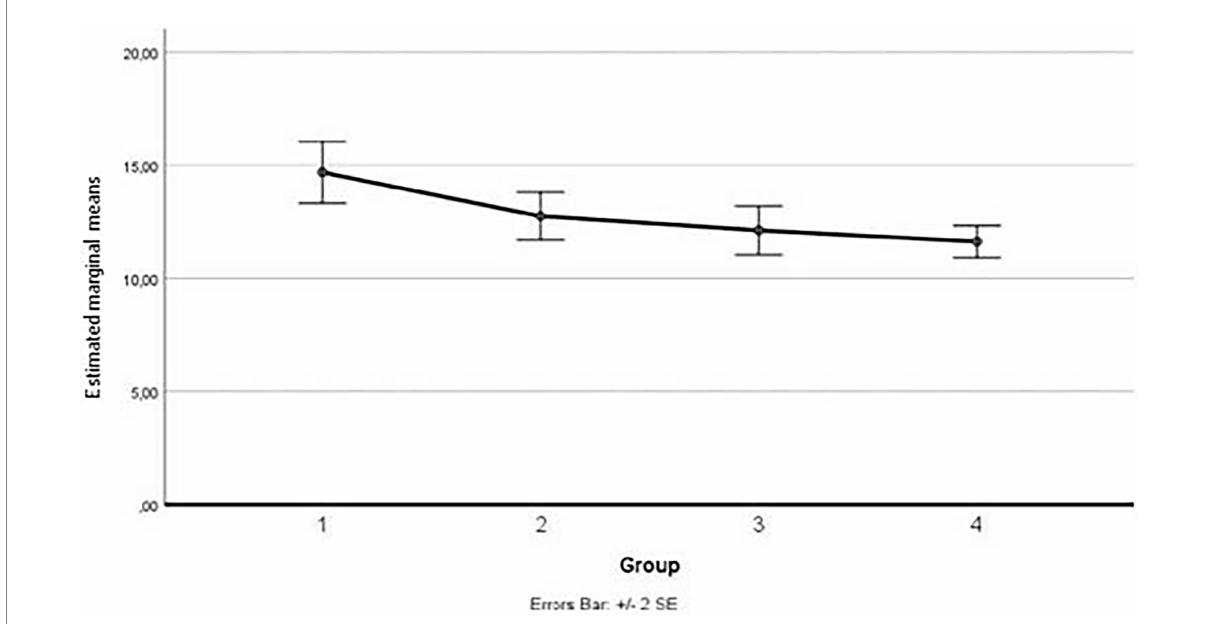
FIGURE 4 Estimated marginal means for the fear of severe pain (after the vision of